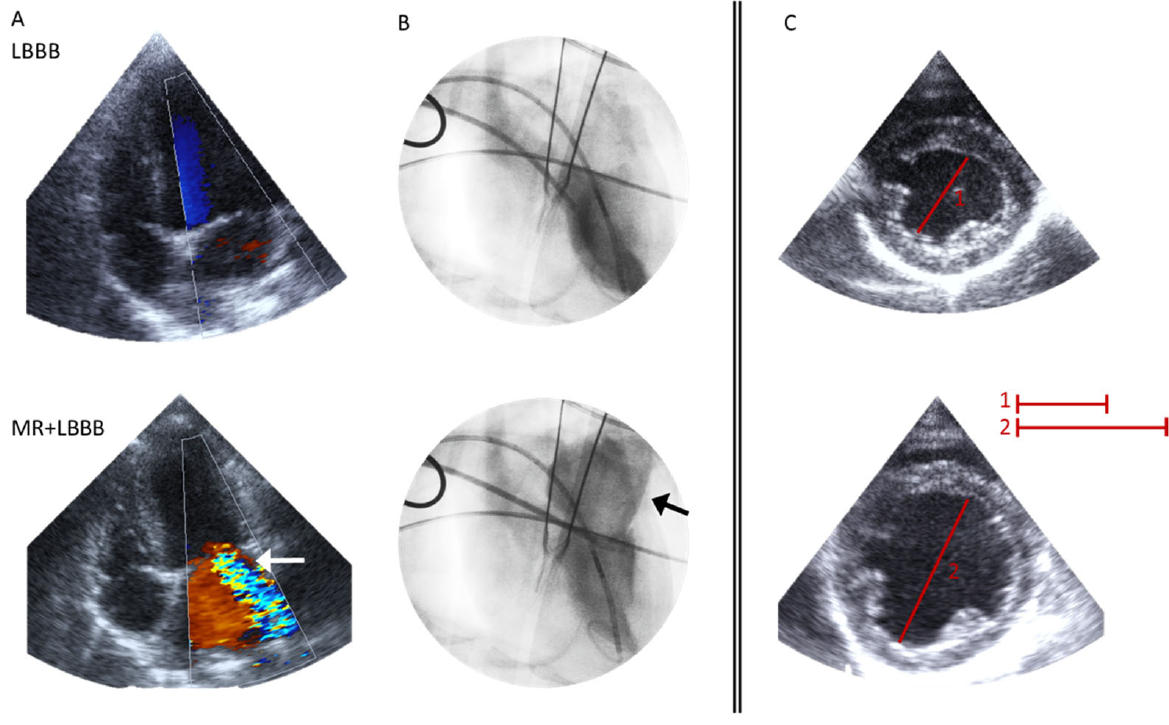
Figure 1. Evaluation of mitral regurgitation. ( A , B ) Representative perioperative recordings of a dog with LBBB (top panels) and MR + LBBB (bottom panels). ( A ) Four-chamber recording with color Doppler, showing a clear eccentric jet (white arrow) after ablation of chorda(e) in an MR + LBBB dog. ( B ) Fluoroscopic recording illustrating MR severity; black arrow indicates regurgitant flow into the left atrium. ( C ) Postoperative short-axis recording at week 16 (images have the same scale). Red lines show a clear increase in left ventricular internal diameter in diastole.